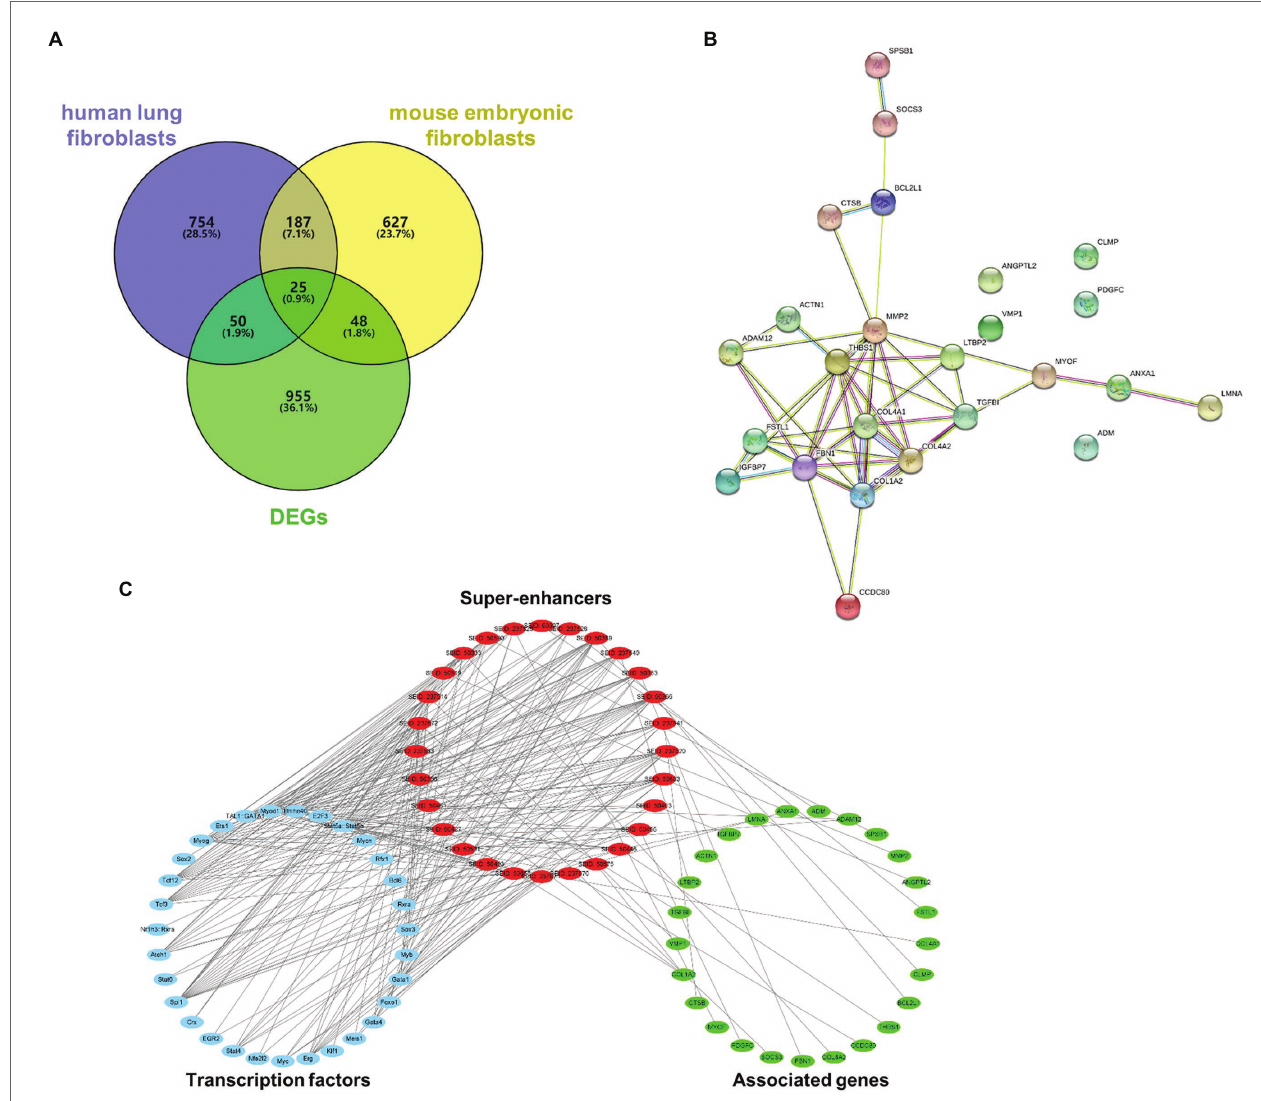
FIGURE 1 | Prediction of potential super-enhancer-driven pathogenic genes in PF. (A) Venn diagram of upregulated DEGs in lungs of PF mice from a GEO dataset (GDS1492) and super-enhancer-associated genes in human lung fibroblasts and mouse embryonic fibroblasts from the SEA database. (B) A PPI network of the 25 super- enhancer-driven pathogenic genes was generated using the STRING database. (C) The interaction network of TFs, super-enhancers, and associated genes in